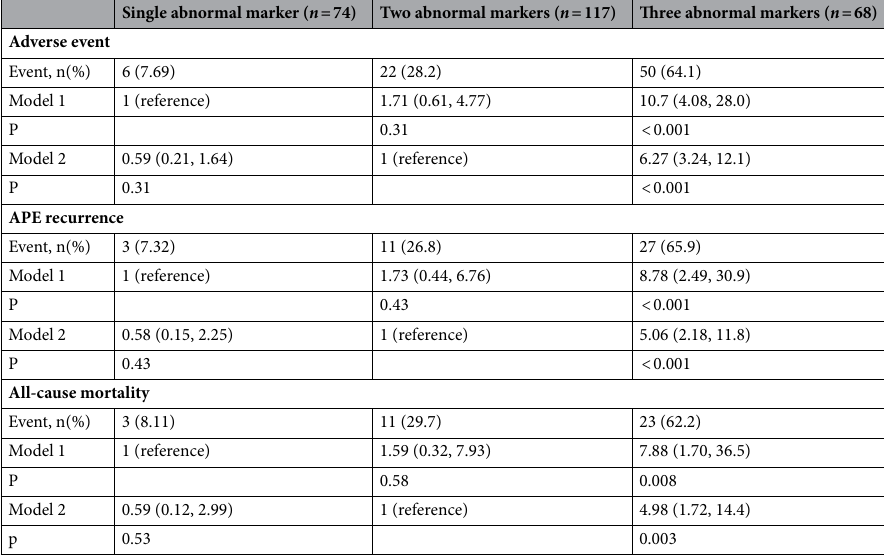
Table 2. Association between number of abnormal markers (D-dimer, N-Terminal Pro-Brain Natriuretic Peptide, and troponin I) and acute pulmonary embolism prognosis. Values are hazard ratio (95% confidence interval). Model 1 used Group 1 (single abnormal marker) as reference, while Model 2 used Group 2 (Two abnormal markers) as reference. Models adjusted for age, sex, heart rate, SBP, smoking, alcohol